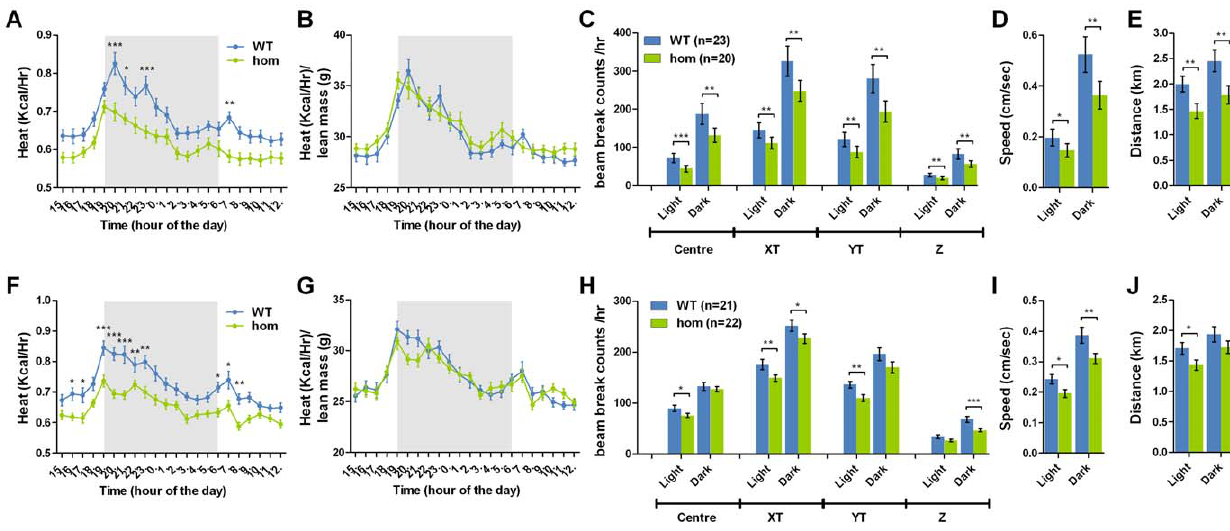
Figure 6. Negr1 –I87N mice have unchanged energy expenditure relative to lean mass and reduced physical activity. A,B,F,G . Energy expenditure (A, F) normalised to lean mass (B, G) over a 22-hr period during light and dark phases in 16-week old wild-type (female, n=23; male, n=21) and homozygotes (female, n=20; male, n=22) females (A–B) and males (F–G). C–E, H–J . Physical activity as measured by the average number of beambreak counts in various different dimensions (C, H), average speed (D, I) and total distance travelled (E, J) in 16-week old wild-type (female, n=23; male, n=21) and homozygotes (female, n=20; male, n=22) females (C–E) and males (H–J). All data are presented as mean 6 SEM. Two-tailed Student’s t -test was carried out between groups, *, P , 0.05; **, P , 0.01; ***, P , 0.001. Bonferroni correction was applied to adjust for multiple measurements (A,B,F,G).